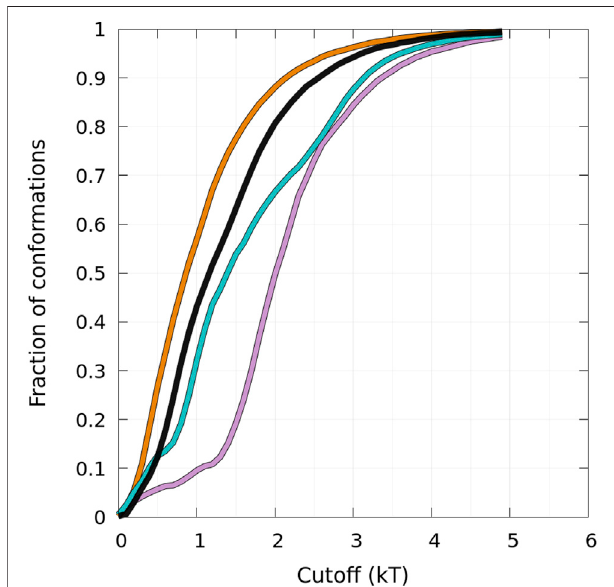
FIGURE 5 | Cumulative fraction of the total number of conformations simulated as a function of an effective free-energy cut-off from the global minimum of the B state (see text) represented in Figure 4 . The curves are for the WT (black), A30P (purple), E46K (turquoise), and A53T